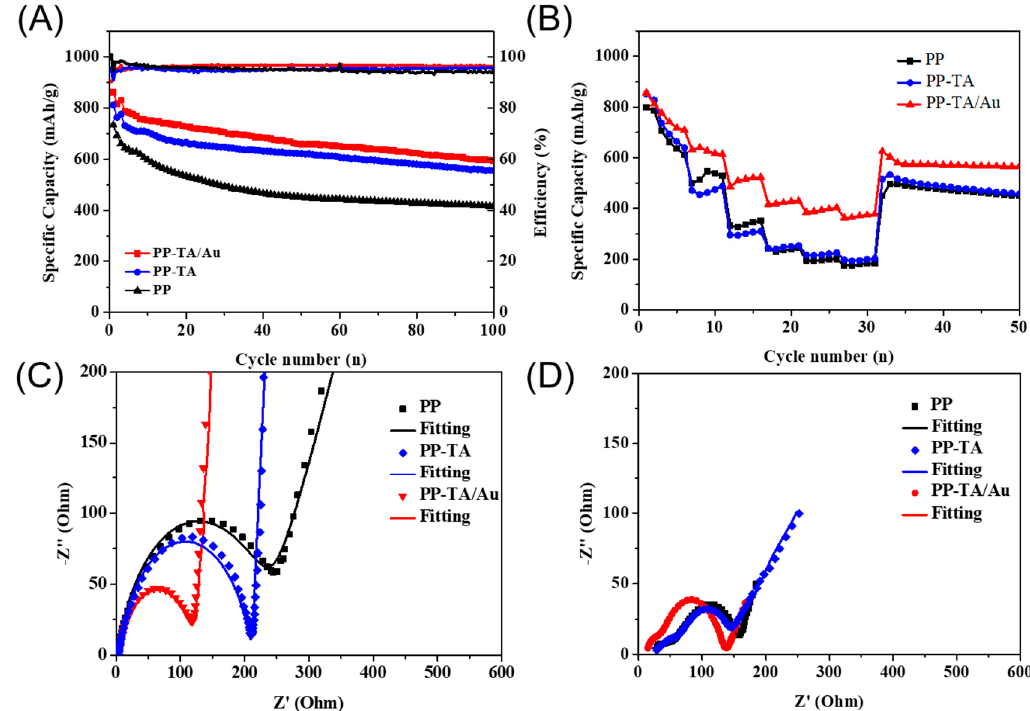
Figure 5. ( A ) Cycling performance of Li-S battery assembled with PP, PP-TA and PP-TA/Au ( B ) Rate performance of Li-S battery assembled with PP, PP-TA and PP-TA / Au separator. ( C ) EIS separator. ( B ) Rate performance of Li-S battery assembled with PP, PP-TA and PP-TA/Au separator. spectra of uncycled Li-S battery assembled with PP, PP-TA and PP-TA / Au separator. ( D ) EIS spectra of ( C ) EIS spectra of uncycled Li-S battery assembled with PP, PP-TA and PP-TA/Au separator. ( D ) EIS cycled Li-S battery assembled with PP, PP-TA and PP-TA / Au spectra of cycled Li-S battery assembled with PP, PP-TA and PP-TA/Au separator.